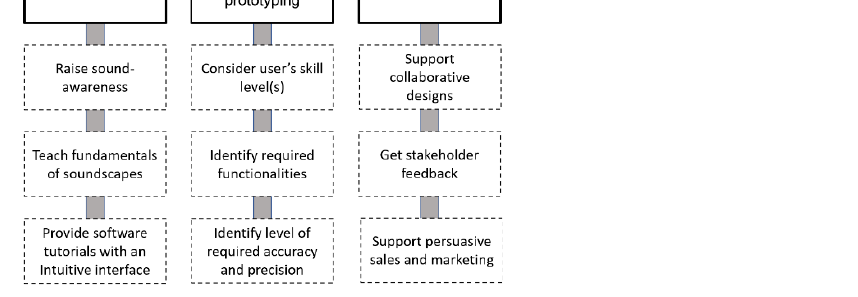
Figure 7. Three main categories of uses for soundscape sketchpads with considerations to support